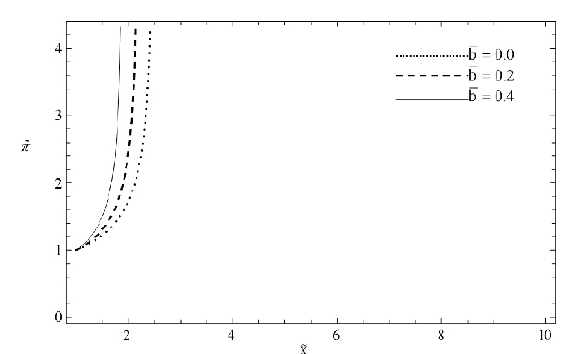
˜ π ) for m = 2 , ω = − 0 . 5 and